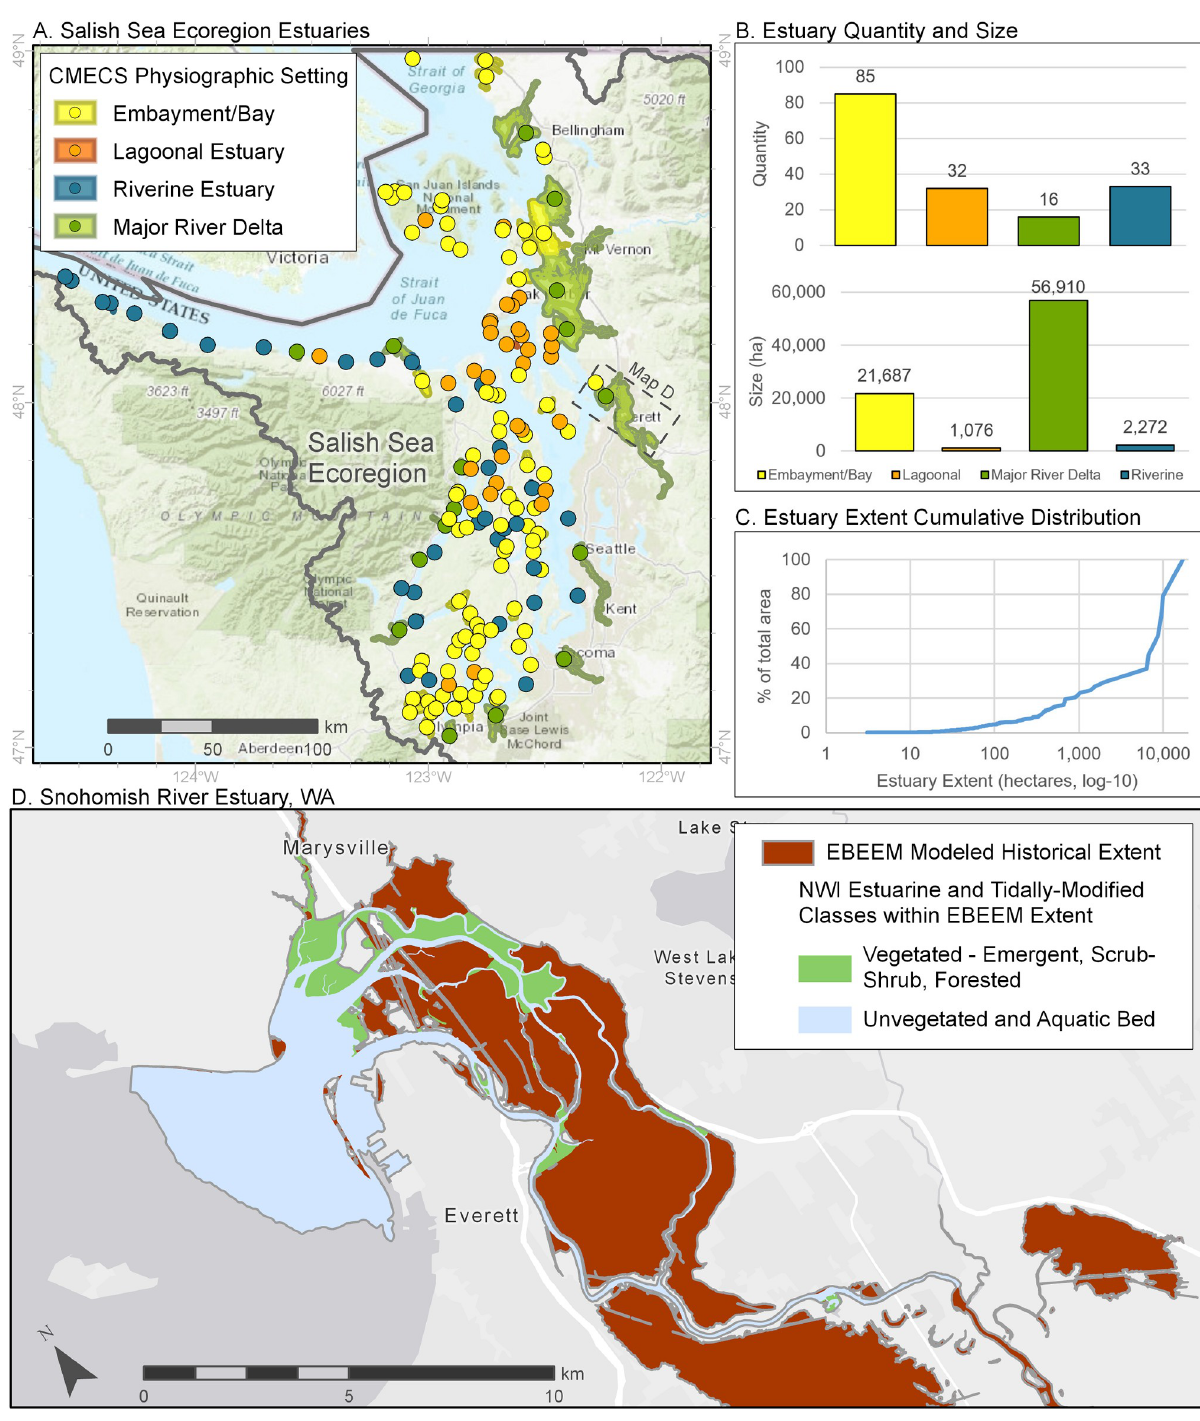
Fig 7. Summary of estuaries in the Salish Sea/WA coast ecoregion of the Pacific Coast (Washington, Oregon and California). Map in upper left panel (A) shows the number and extents of estuaries by physiographic type. Upper right panel (B) shows the extent percent representation of each estuary type as calculated by the number of each type (Quantity) and by areal coverage (Size), while the middle right panel (C) illustrates the cumulative distribution function of the number of estuaries as a function of their size in hectares (ha). The map in the lower panel (D) illustrates an example estuary from each the ecoregion including spatial extent of historical footprint based on 50% exceedance contour (“EBEEM”) and area of current tidal wetlands based on National Wetland Inventory classes (“NWI”), data used to calculate habitat loss. Note: Unvegetated and aquatic bed areas shown in blue are within the EBEEM Historical extent, but were excluded from the wetlands loss